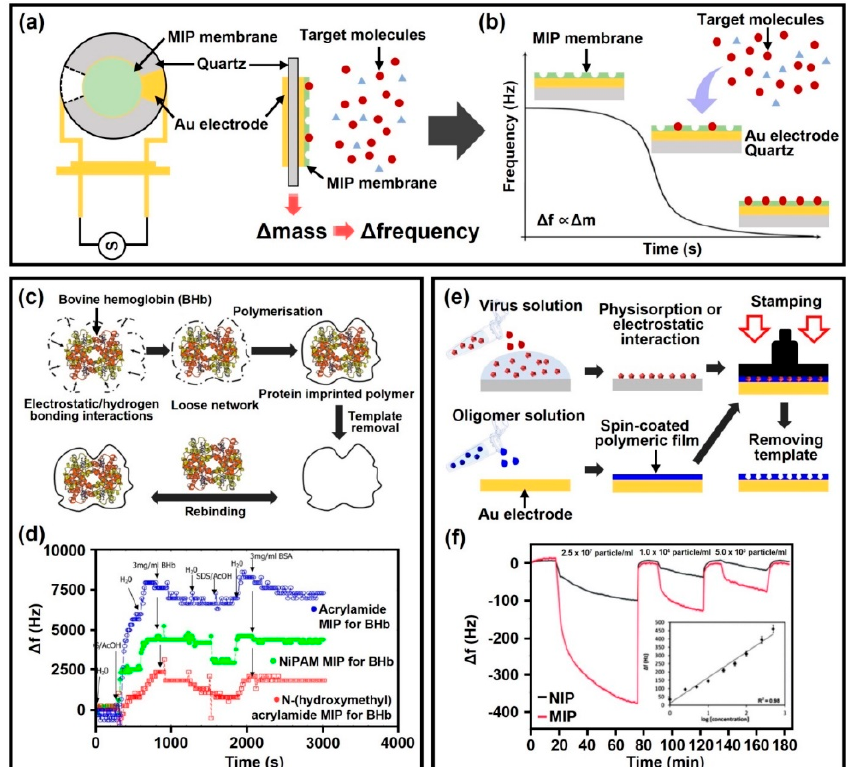
Figure 4. ( a ) A conceptual design for an MIP-based QCM sensor capable of selective adsorption of target molecules. ( b ) Frequency change in QCM transducer according to mass change due to binding between the target molecules and artificial receptors formed on the MIP membrane. ( c ) A synthetic strategy to prepare hydrogel-based MIPs for BHb protein adsorption. Reproduced with permission from [119]. Copyright The royal society of chemistry, 2014. ( d ) Frequency response of polyacrylamide-based MIPs to BHb and BSA protein. Reproduced with permission from [119]. Copyright The royal society of chemistry, 2014. ( e ) Schematic illustration of a molecular imprinting process using template stamp coated with influenza virus. ( f ) Frequency changes of MIP- and NIP-based QCM sensor at different concentrations of H1N3 influenza A virus; the inset shows a change in the frequency according to virus concentration (r 2 = 0.98). Reproduced with permission from [114]. Copyright The royal society of chemistry, 2013.